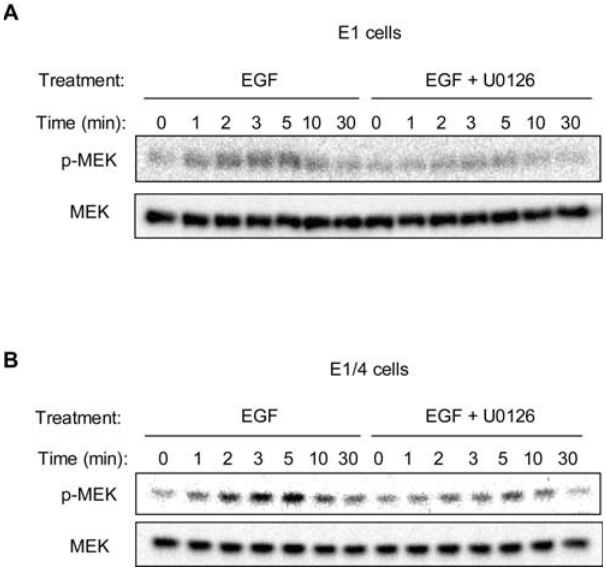
Figure 1. The effect of MEK inhibitor U0126 on MEK phosphorylation in E1 and E1/4 cells. Serum-starved E1 and E1/4 cells were incubated with 10 nM EGF for the indicated time period with or without pretreatment of 200 nM U0126. MEK phosphorylation was analyzed by Western blot with the corresponding anti-phospho-specific MEK antibodies (upper panel), and then reblotted with an anti-MEK antibody (lower panel). (A) Western blot for E1 cells. (B) Western blot for E1/4 cells. Data show a representative figure of three independent experiments. Quantified data are available in Table S1 (no. 3).